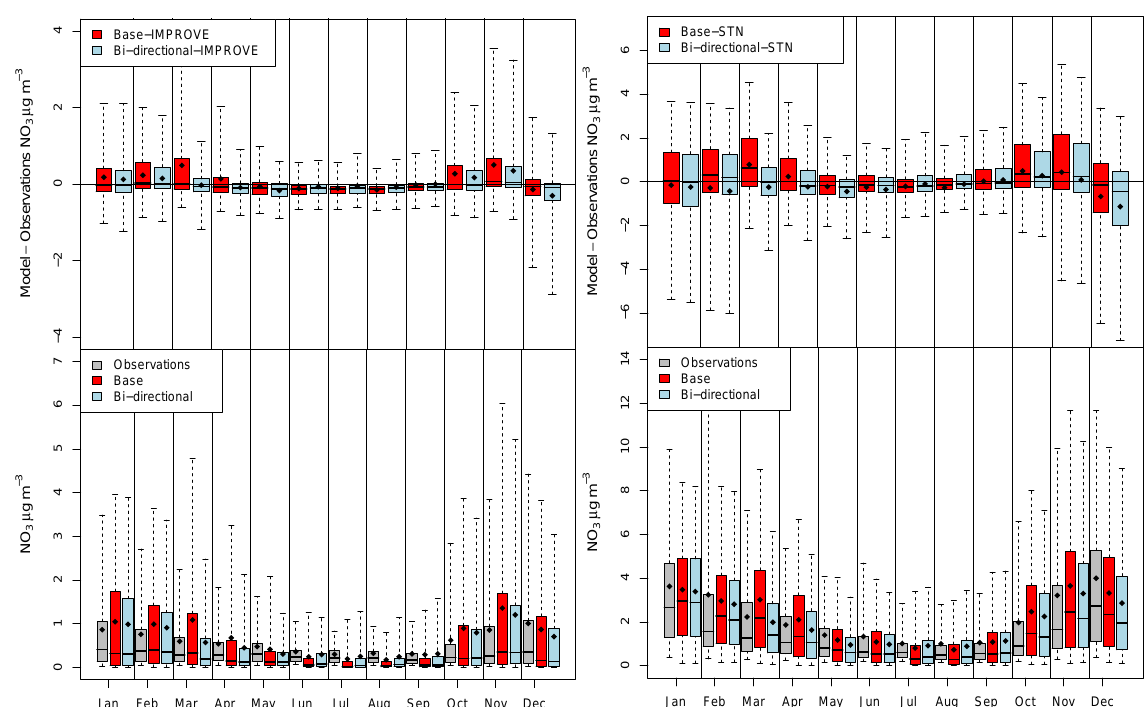
Fig. 6. Box plots of modeled monthly ambient NO − aerosol biases and concentrations at STN (top two panels; N = 871 to 1236 per month) 3 and IMPROVE sties (bottom two panels; N = 691 to 1135 per month). The base case is in red, the bidirectional case is in blue and STN and IMPROVE observations are in grey. The boxes enclose the 25th to 75th percentile, the whiskers represent the 5th and 95th percentiles, the horizontal bar represents the median, and the black diamond represents the